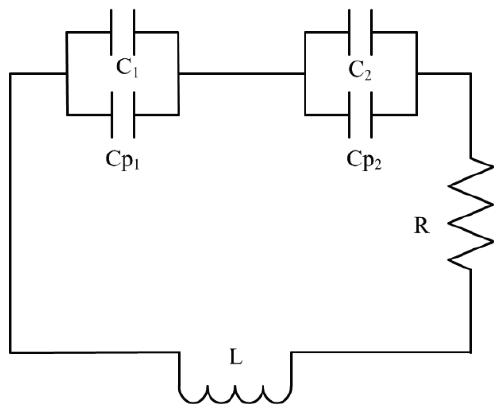
Figure 3. Equivalent circuit of the proposed unit cell.